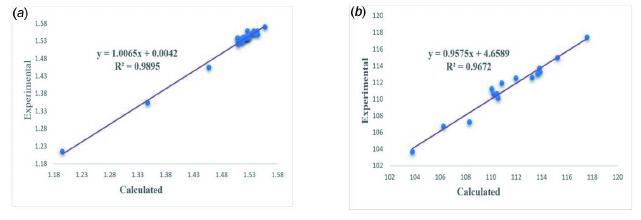
Figure 7 The correlation graphs of the calculated and experimental ( a ) bond lengths and ( b ) bond angles of the title compound,